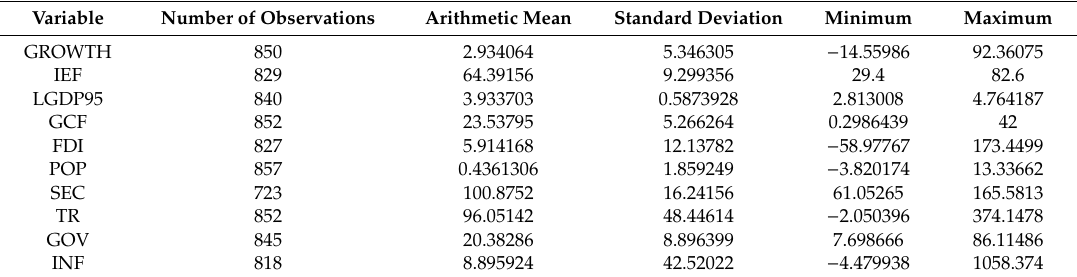
Table 1. Descriptive statistics of all